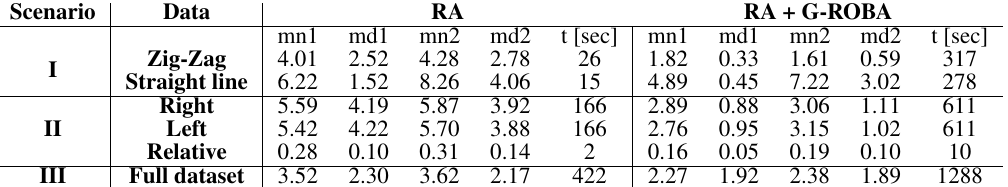
Table 3: Comparison of the real-world results against the baseline dataset (Bryson et al., 2013) divided into three scenarios. (1) The data are partitioned into two sets, a zig-zag path (6278 stereo images), and a straight path (5000 stereo images), and solved independently from one another. Both sets are compared to their baseline counterpart, respectively. (2) The data are partitioned into left (11278 images) and right (11278 images) images. The two sets are then compared to their baseline counterpart and to one another (relative rotation between the left and right trajectories). (3) Full dataset (11278 stereo images). In all experiments, the RA + G-ROBA outperformed the RA, error-wise. the establishment of a view-graph for the image set, the ini- tialization by applying a rotation averaging procedure, and the generalized refinement of the global rotations. The